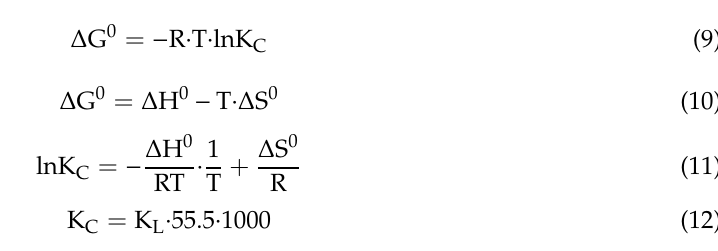
Table 6. Summary of thermodynamic parameters: Gibbs free energy, enthalpy and entropy for the adsorption of aqueous Ba 2 + by ALO, BEI and ZEO with(out) FeO-modification. ∆ G 0 (kJ / mol) ∆ H 0 (kJ / mol) ∆ S 0 (kJ / mol · K) Adsorbent 288 K 298 K 313 K ALO − 25.69 − 26.97 − 30.13 3.13 0.022 FeO-ALO − 29.63 − 30.73 − 32.59 0.54 0.014 BEI − 29.11 − 30.49 − 32.44 FeO-BEI − 30.46 ZEO − 30.46 − 31.60 − 33.49 FeO-ZEO − 29.20 − 30.74 − 32.36 0.82